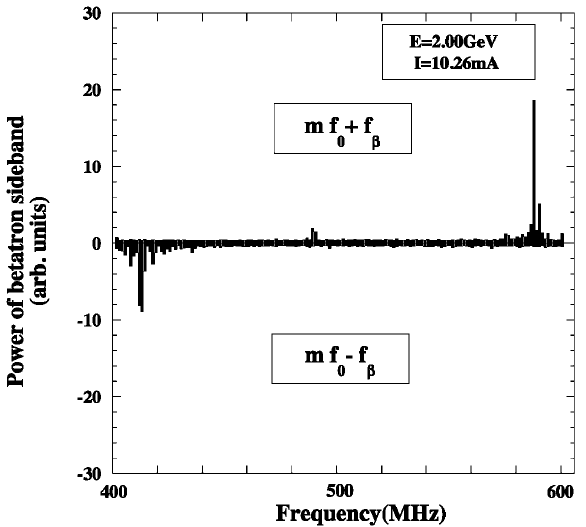
FIG. 1. Vertical betatron sidebands at a beam energy of 1.55 GeV. The positive and negative values correspond to (cid:4) f (cid:11) f mf and mf , respectively. (cid:21) (cid:21) 0 0